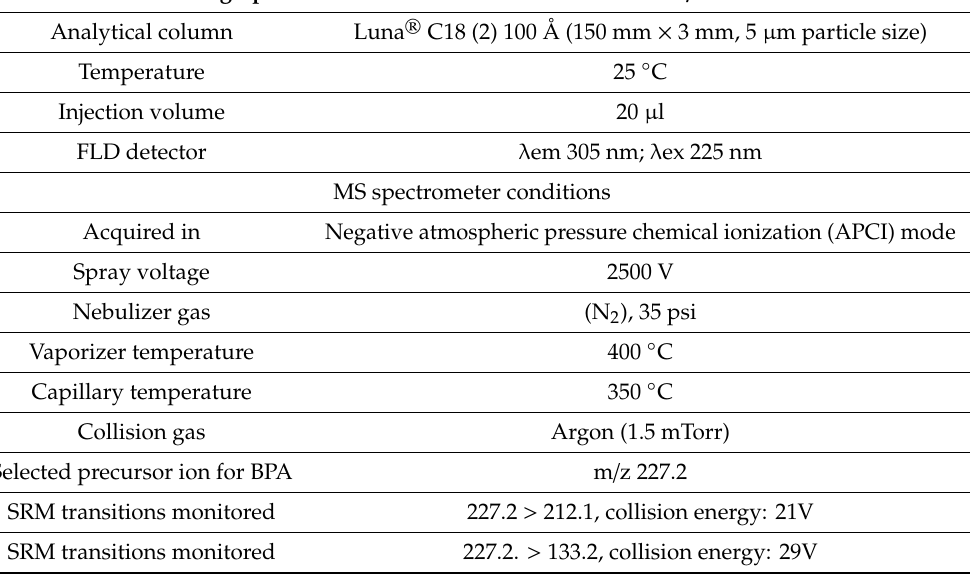
Table 2. Chromatographic conditions for the determination of bisphenol A (BPA) as results of its migration to canned vegetables.